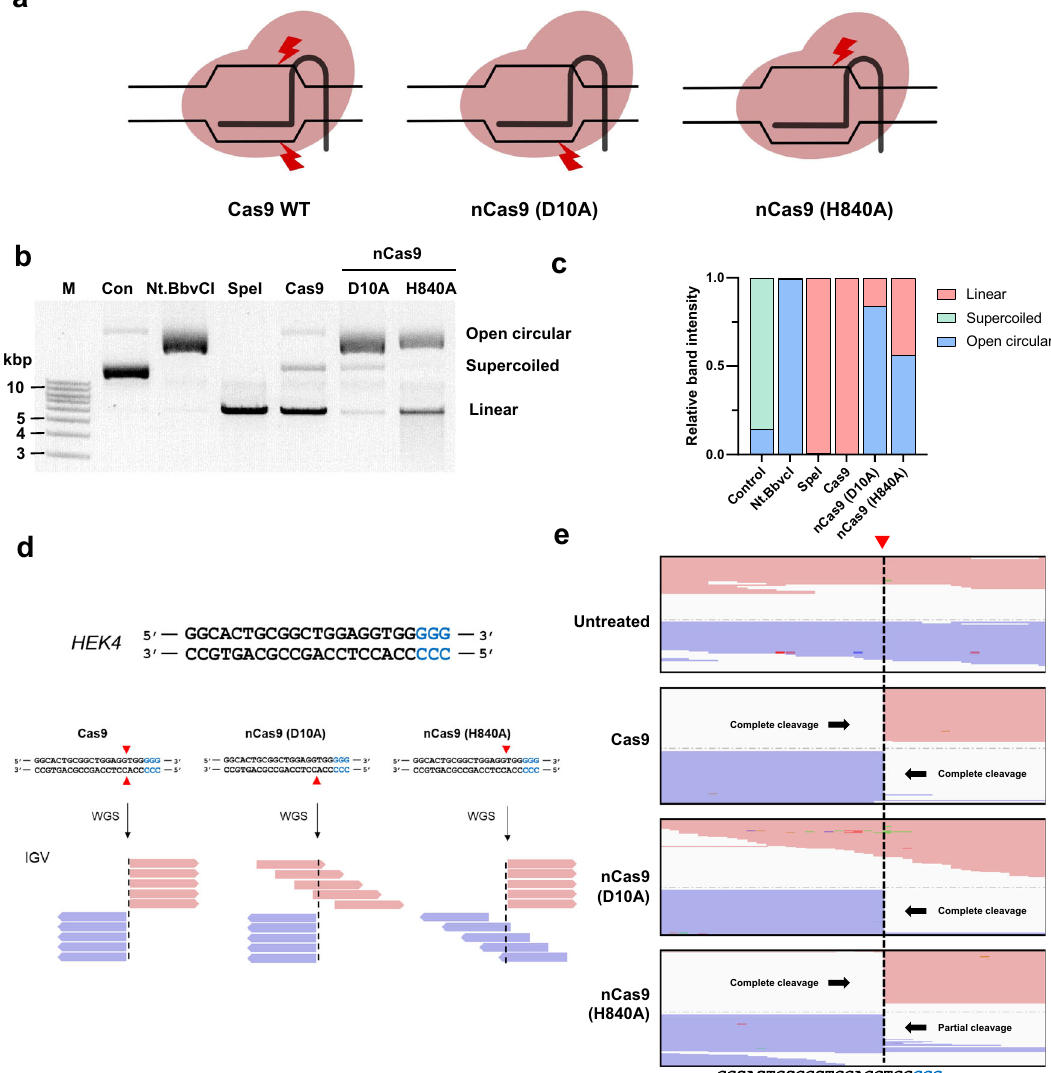
Fig. 1 | nCas9 (H840A)cancreate DSBs.a A schematicdiagramof the anticipated cleavagepatternsofWTCas9,nCas9(D10A),andnCas9(H840A). b Invitroplasmid digestion assay. Supercoiled plasmids were digested with nicking endonuclease Nt.BbvCI,restrictionenzymeSpeI,andpuri fi edWTCas9,nCas9(D10A),andnCas9 (H840A)proteins.NicksorDSBsinsupercoiledplasmidsgenerateopen-circularor linear forms, respectively. c Relative band intensities of the supercoiled, open cir- cular,andlinearformswerecalculatedusingImageJsoftware. d Expected cleavage